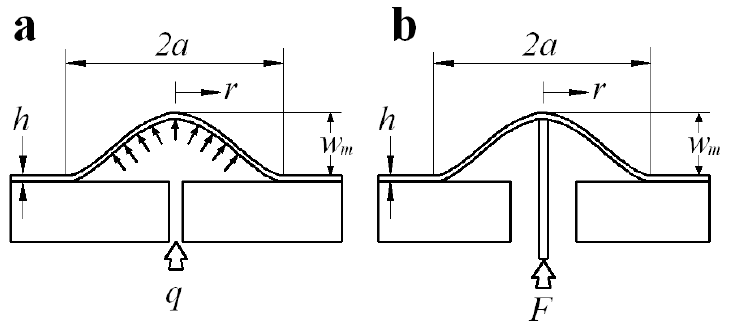
Figure 1. Sketches of the loading configuration of blister tests. ( a ) a pressurized circular blister configuration and ( b ) a shaft-loaded circular blister configuration.